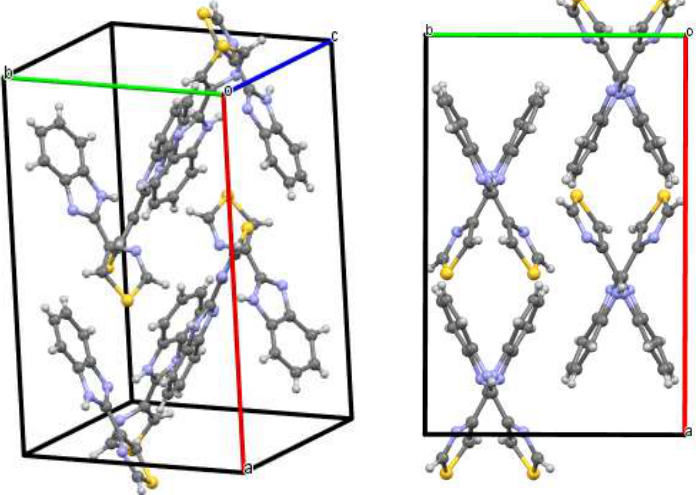
Figure 4. Unit cell of the room temperature crystalline form of thiabendazole. The crystal is orthorhombic, Pbca space group, with a , b , c equal to 17.052(7), 10.998(4) and 10.030(8) Å ( α , β , γ = 90°), and 8 molecules per unit cell [11].